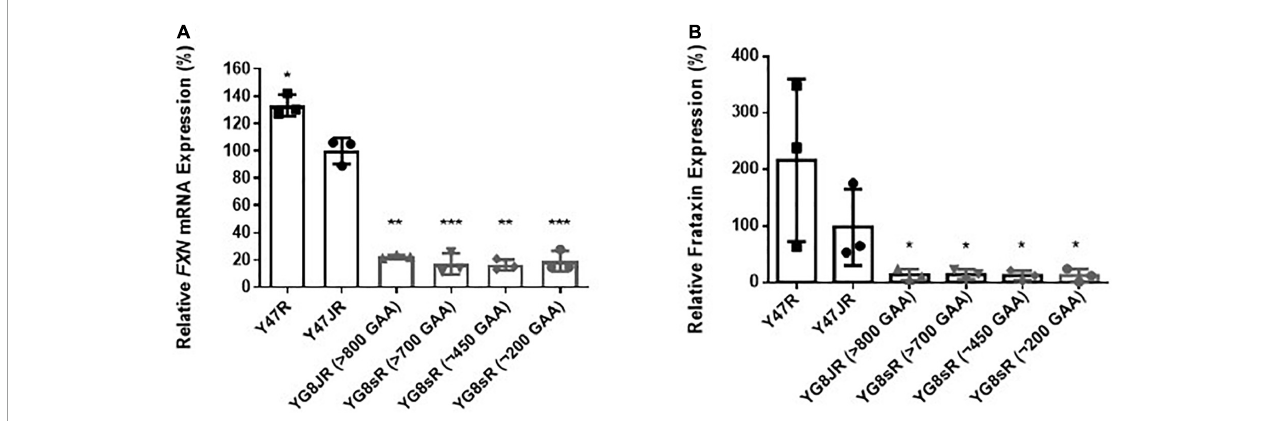
FIGURE4 Frataxin expression levels. (A) Quantitative RT-PCR analysis of FXN mRNA extracted from FRDA and control mouse brain tissues ( n = 3) using FXN mRNA with mouse-human specific primers. The experiments were repeated 2–3 times for each genotype and performed in triplicates. Data were normalized to the mean frataxin level of Y47JR samples taken as 100%. Values represent mean ± SD. Asterisks indicate significant differences compared to Y47JR mice, assessed by unpaired two-tailed Student’s t -test (* p < 0.05, ** p < 0.01, and *** p < 0.001). (B) Relative densitometric bar graphs of Frataxin in brain tissues of FRDA and control mice ( n = 3, 2–3 independent experiments). Tubulin was used as protein loading control. Data were normalized to the mean frataxin level of Y47JR samples taken as 100%. Values represent mean ± SD. Asterisks indicate significant differences compared to Y47JR control mice, assessed by unpaired two-tailed Student’s t -test (* p < 0.05). Two control (Y47R and Y47JR) and four FRDA [YG8JR ( > 800 GAA), YG8sR ( > 700 GAA), YG8sR ( ∼ 450 GAA), and YG8sR ( ∼ 200 GAA)] mice were used.